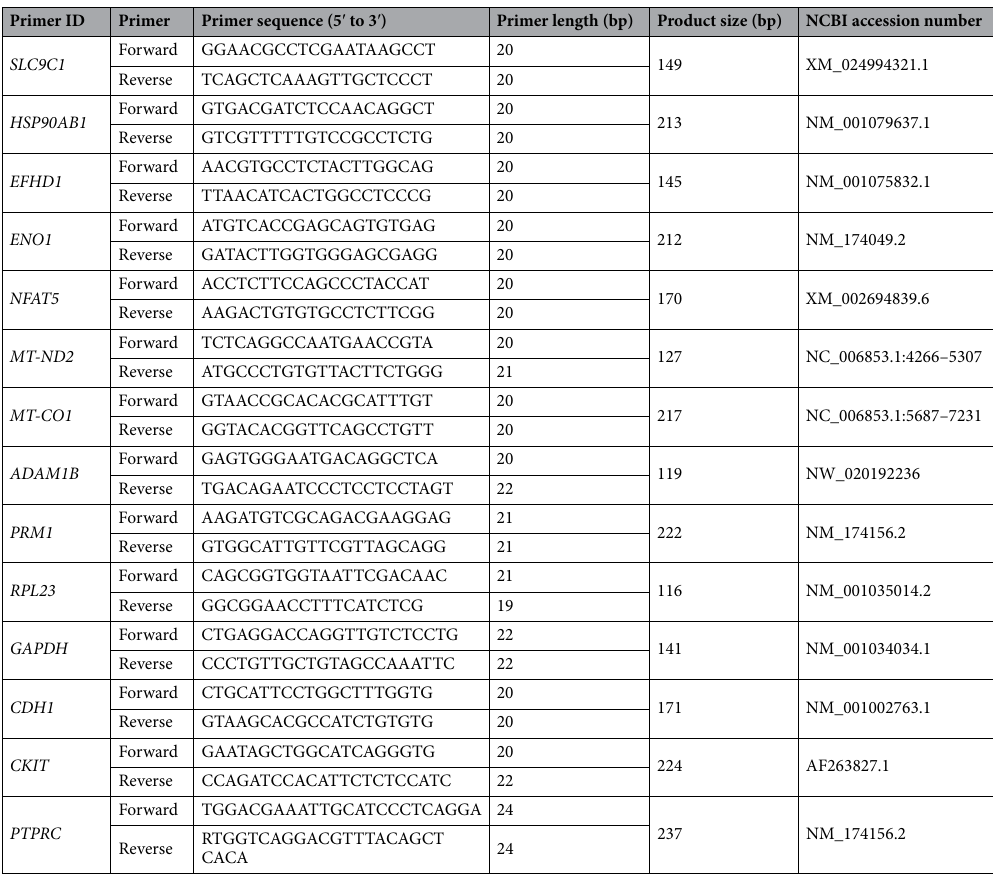
Table 2. The details of the Primers used for gene expression studies in the